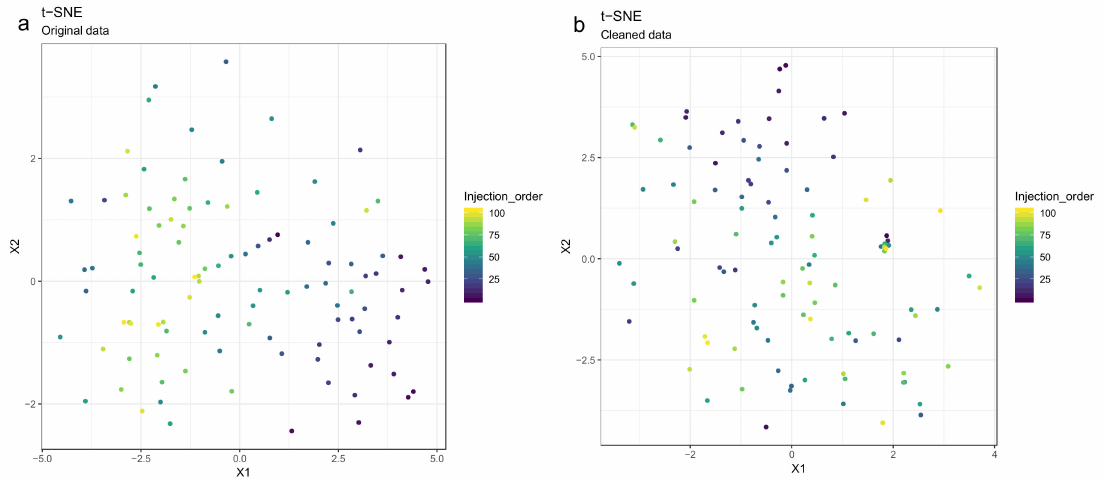
Figure 9. The drift pattern in the injection order (the color trend) using the t-distributed stochastic neighbor embedding (t-SNE) method is visible before drift correction ( a ), whereas after drift correction ( b ), the samples are more randomly